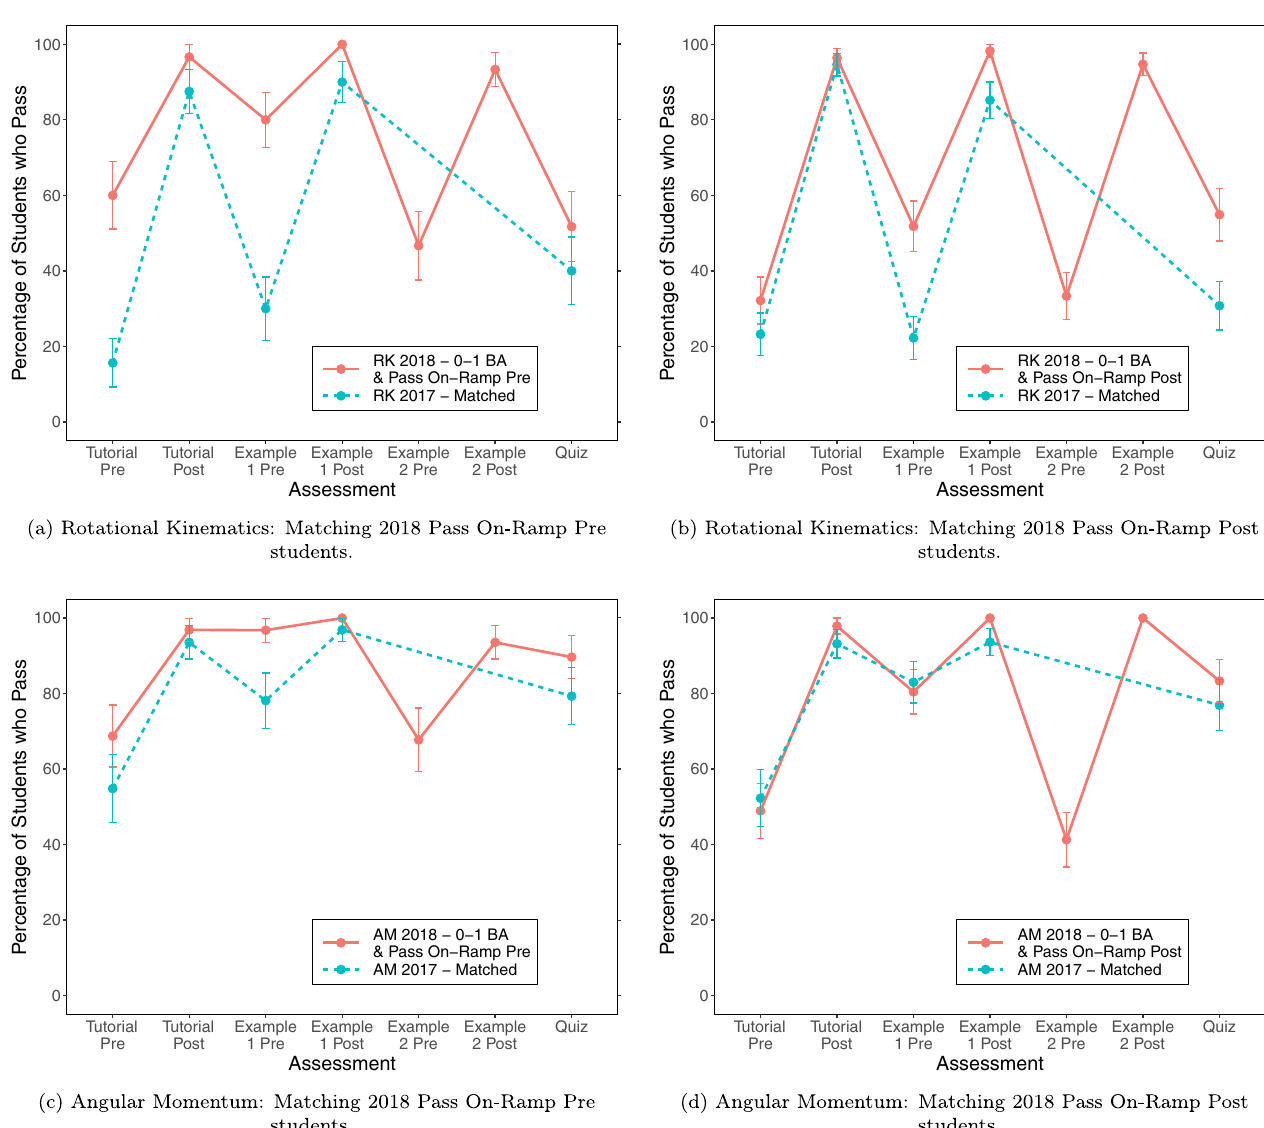
FIG. 5. Comparison of the performance on the pre and post attempts of modules for students with 0 – 1 brief-attempts and different on- ramp performance (a) and (c): Pass On Ramp Pre. (b) and (d): Pass On Ramp Post. The student population in 2017 students was selected to match the background knowledge level of students in 2018 using a propensity score derived from exam scores. Passing rates from the on-ramp modules are not shown. Data on example 2 from 2017 is absent because the module was added in